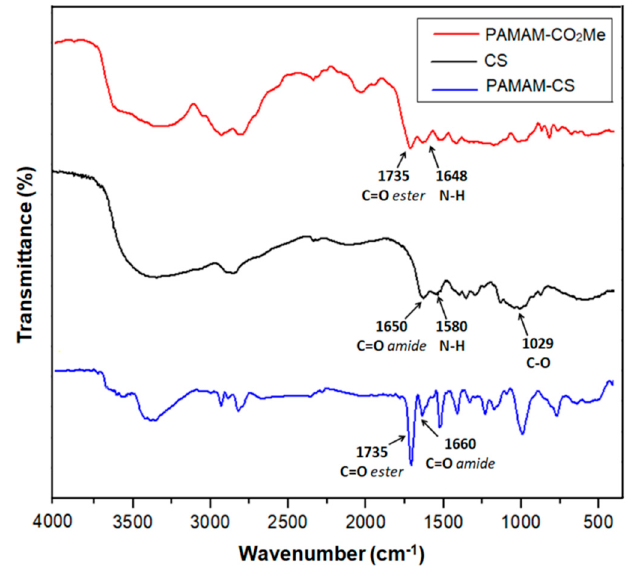
Figure 1. FTIR spectra of CS, CS-PAMAM and PAMAM-CO 2 Me samples.